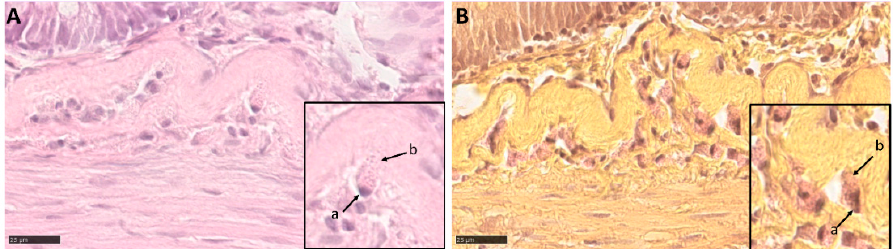
Figure 13. HE ( A ) and phloxine tartrazine ( B ) stained sections showing intestinal eosinophilic granule cells within the granulosum layers of submucosa (a—nucleus; b—eosinophilic granular cytoplasm).